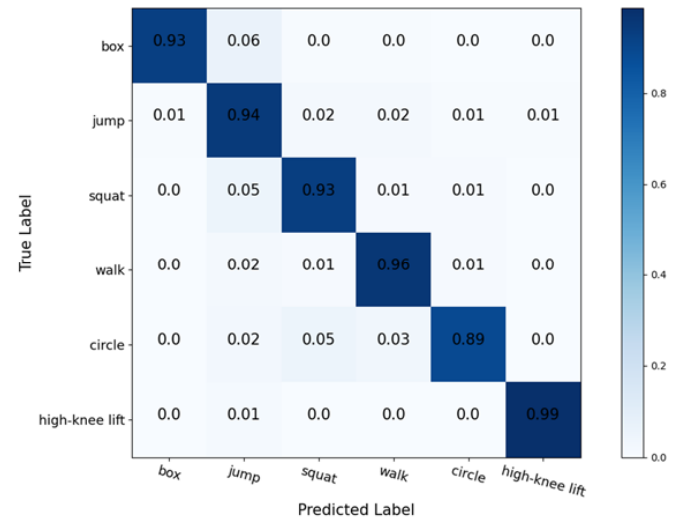
Figure 15. The confusion matrix of 3D CNN network.